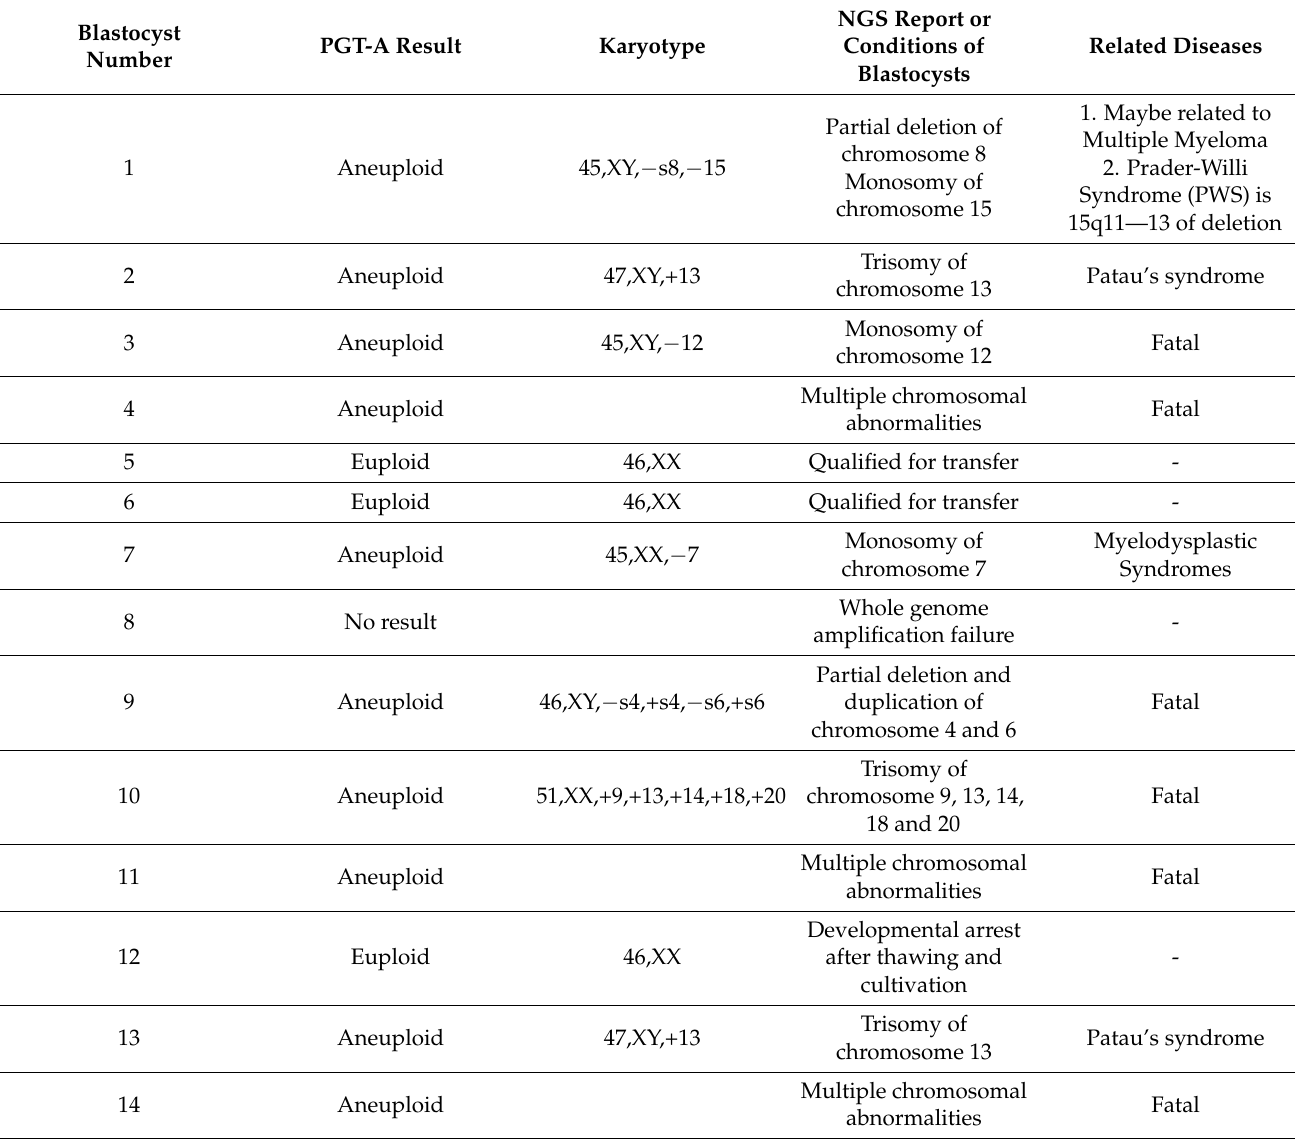
Table 1. Findings of preimplantation genetic testing for aneuploidies (PGT-A) and conditions of euploid blastocysts. Next generation sequencing (NGS)-based PGT-A was performed. PGT-A, preimplantation genetic testing for aneuploidy; NGS, Next generation